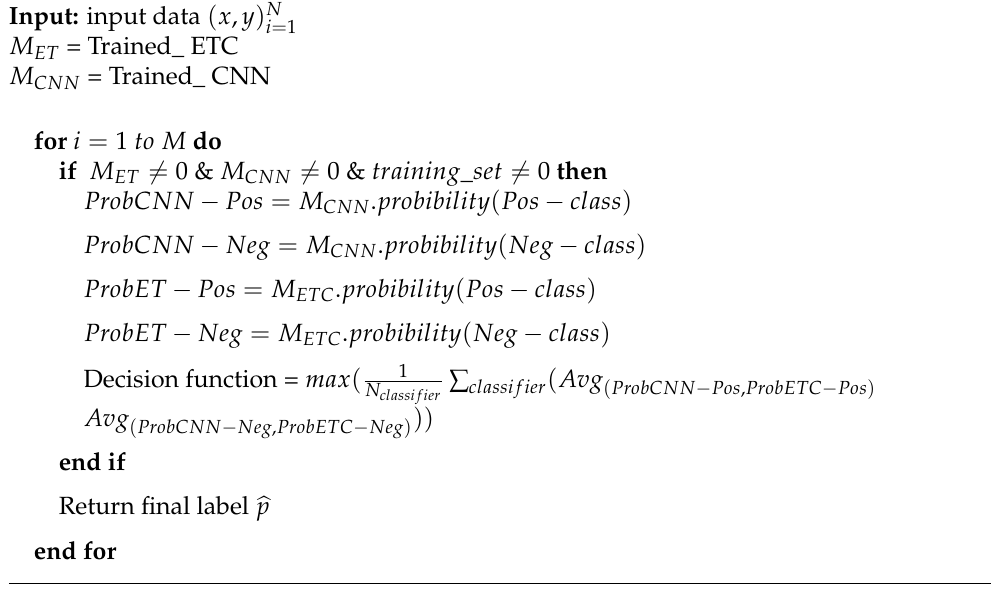
Algorithm 1 Ensembling of ETC and CNN as